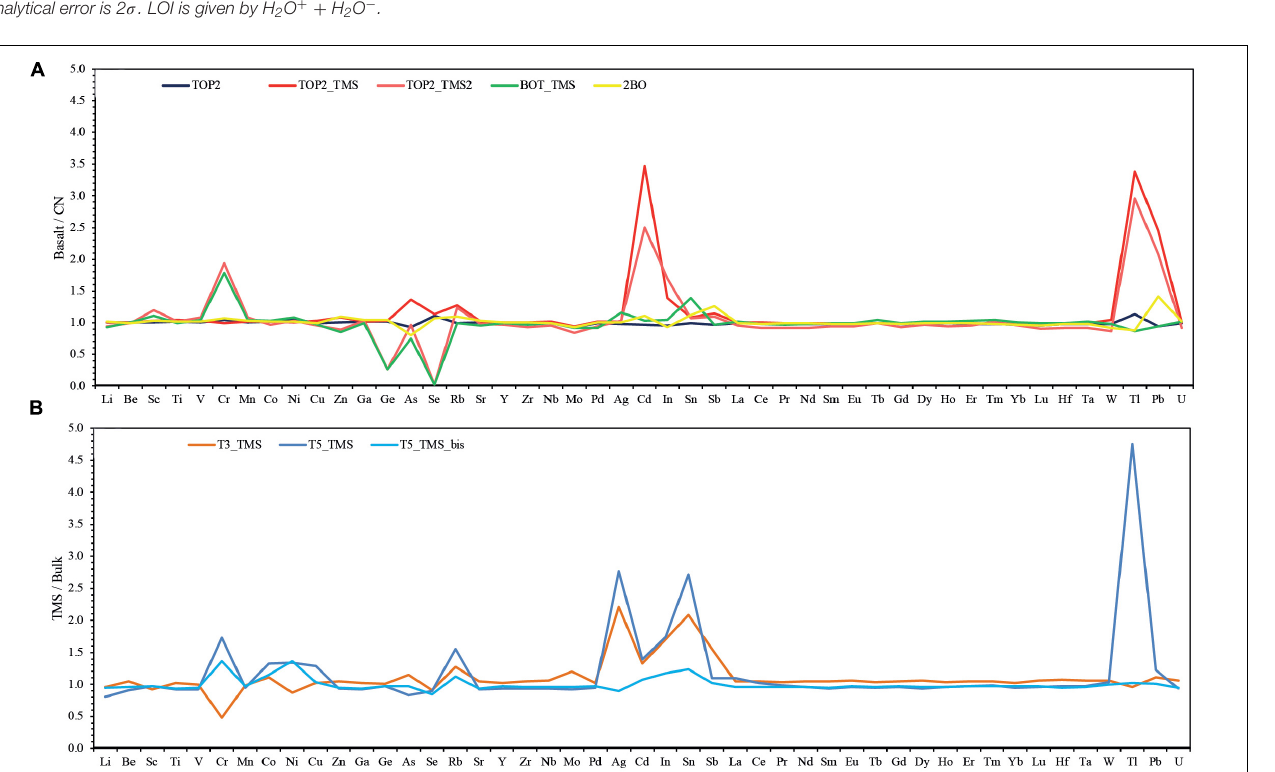
tree-contact samples (T5-TMS and T3-TMS) are enriched in CO 2 (0.35 and 0.41 wt.%), in comparison to bulk sample concentrations of 0.13 and 0.26 wt.%, respectively ( Figure 9